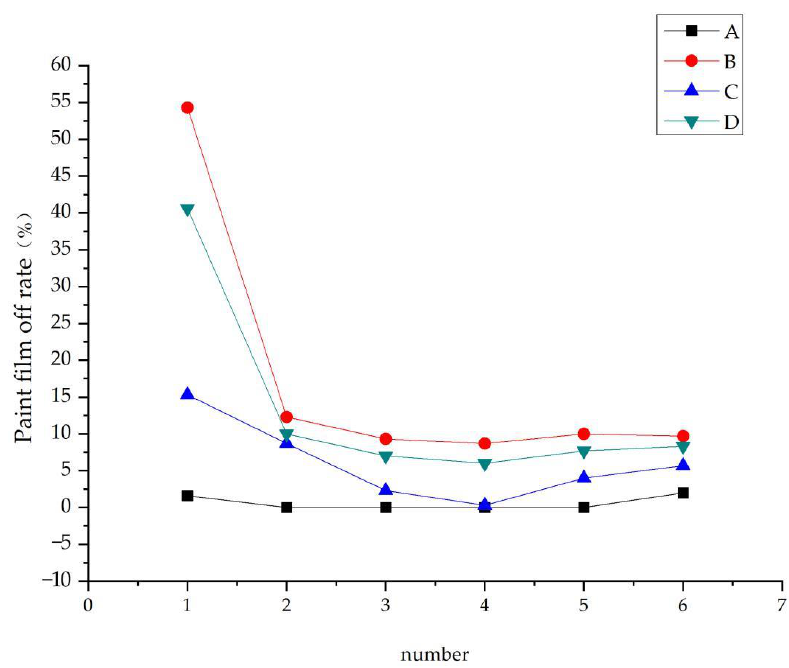
Figure 4. Paint film off rate of each group.